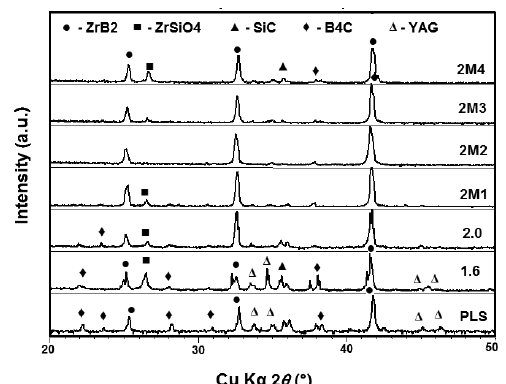
Fig. 1 XRD patterns of PLS [19] and different PLRS composites sintered at 1680 ℃ .